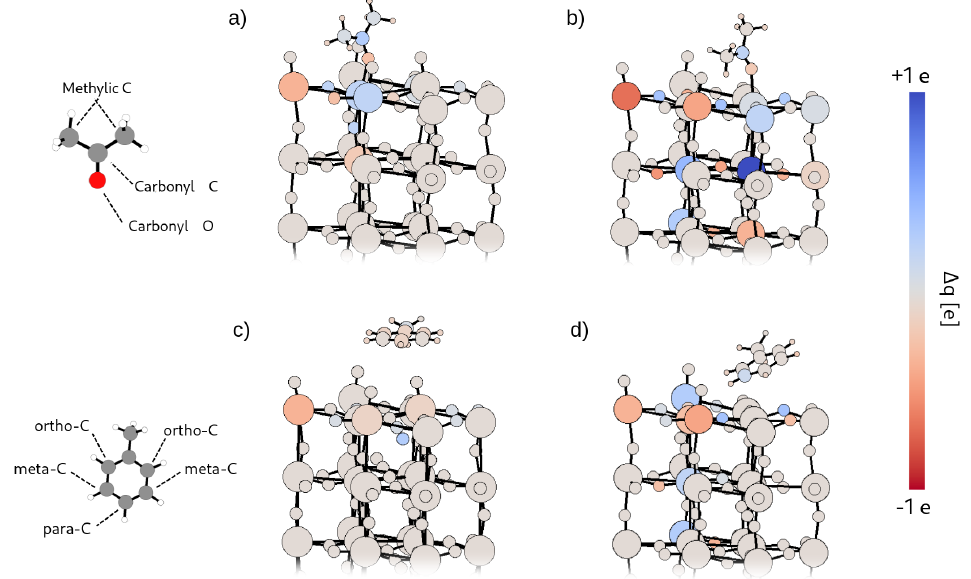
Figure 8. Atomic charge differences color-mapped onto the atomic structures of the systems Ace@Surf ( panel a ), Ace@Surf-V O ( panel b ), Tol@Surf ( panel c ), and Tol@Surf-V O ( panel d ). The charges on the WO 3 surface are referenced to the ones of the isolated surface, i.e., stoichiometric surface or Surf-V O . The charges on the adsorbed molecules are referenced to the ones of the isolated molecule. On the left side are reported the atomic structure of the molecule with labels indicating the chemically different atomic species. The color bar is reported on the right. The same color scale was used for both systems, with an upper and lower limit of 1 electron and − 1